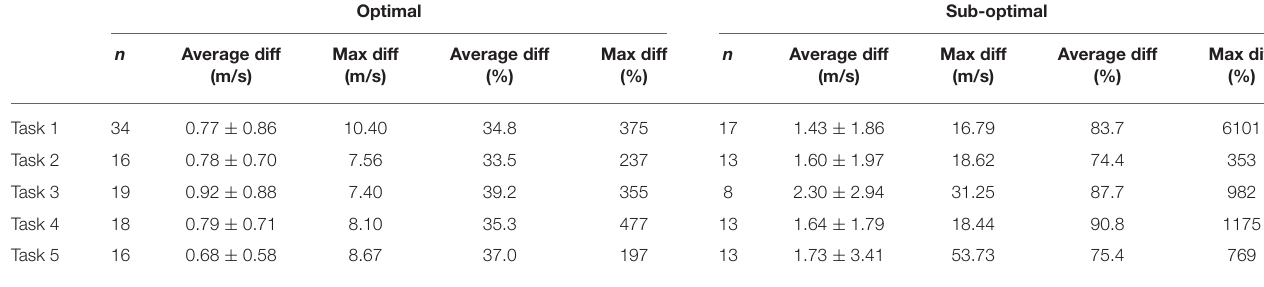
TABLE 3 | Difference between the LPS and reference system for instantaneous speed, for optimal and sub-optimal condition respectively. Optimal